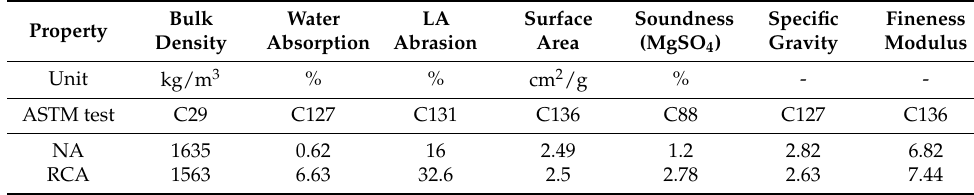
Table 1. Physical properties of coarse